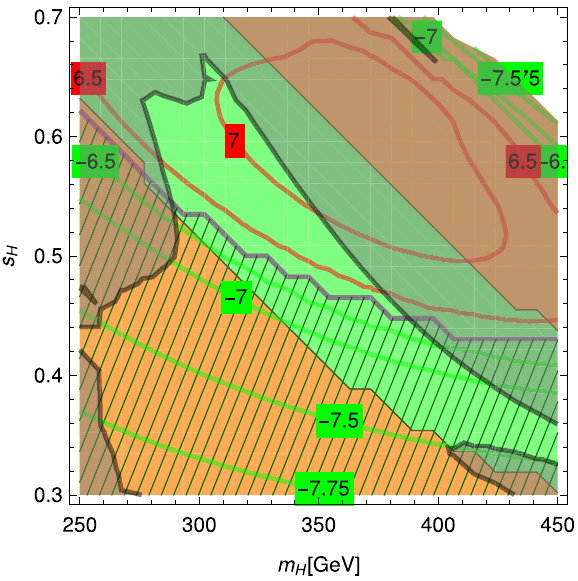
Fig. 15 Comparison of the vacuum stability at tree level and the one- loop level. The shaded areas represent the stability of the potential at tree level: unstable (orange) or stable (green). The green hatched area is stable at the one-loop level. The green, purple and red contour lines show the depth of the loop-corrected ew minimum: the values are sign ( V ) log 10 | V / GeV 4 | . The grey shaded area indicates the pertur- bativity constraints where we have used the MS condition. The other parameter values are λ 2 = 1, λ 3 = 0 . 9, λ 4 = − 0 . 2, λ 5 = 0 . 2, α = 15 ◦